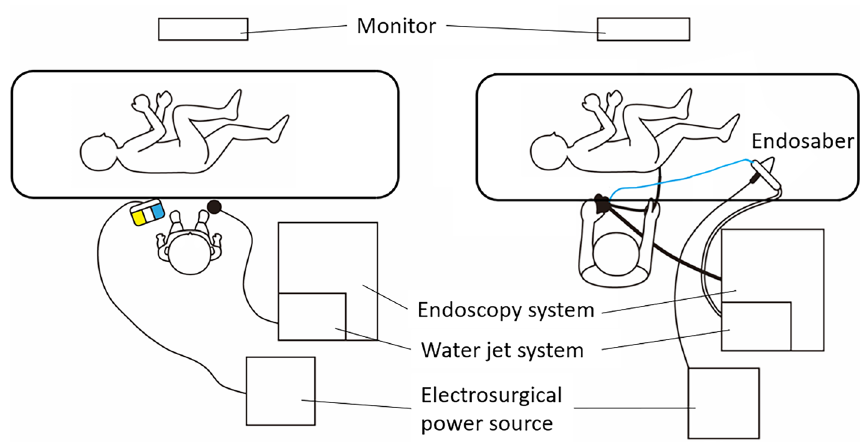
Figure 4. The placement of the related instruments during self-completion endoscopic submucosal dissection. The foot switch of electrosurgical power source is located at the left side of the operator. The foot switch of water jet system is located at the right side of the